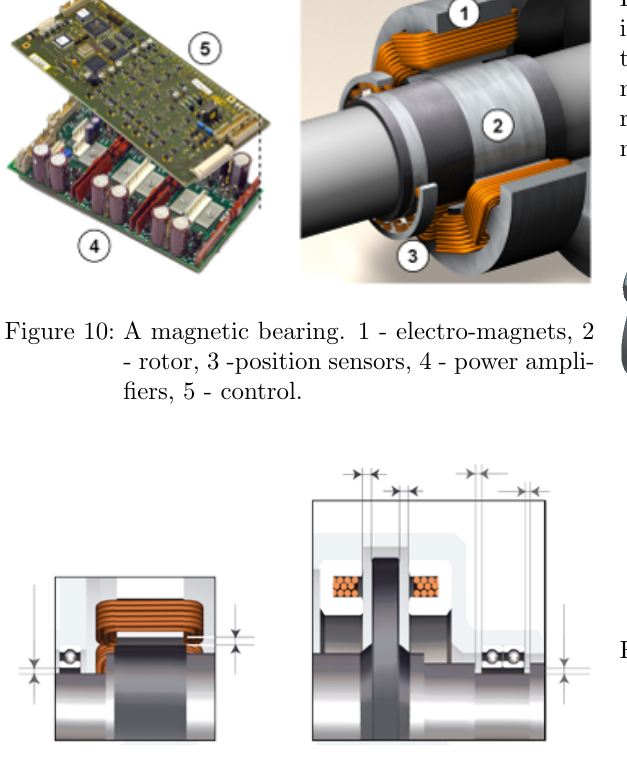
Figure 11: Touchdown bearings which protect the magnetic bearings. Clearances indicated.